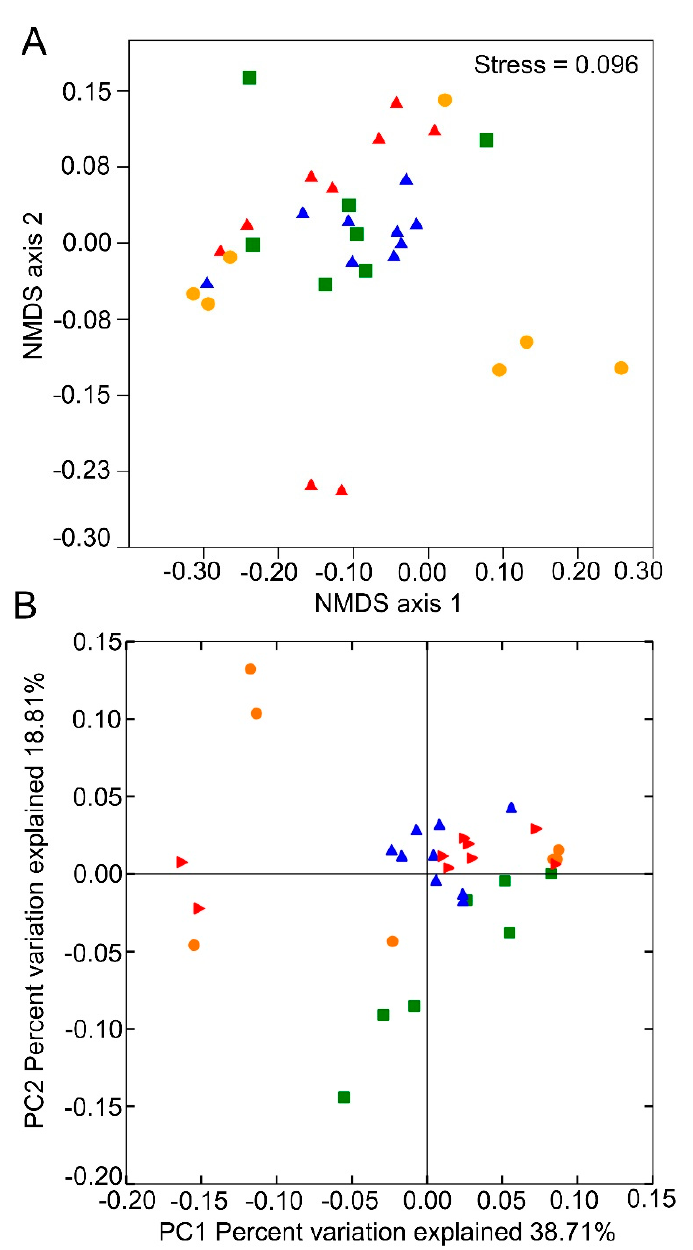
Figure 1. Non-metric multidimensional scaling (NMDS) and principal coordinates analysis (PCoA) of the bacterial communities in the gut of di ff erent life stages of D. valens . ( A ) Non-metric multidimensional scaling diagrams of 32 samples, based on Bray-Curtis distance matrix for bacterial communities that consisted of operational taxonomic units (OTUs) (97% similarity level). ( B ) Principal coordinate analysis plots based on the weighted UniFrac metric for bacterial communities. The red triangle represents young larval gut samples, the green square represents old larval gut samples, the orange circle represents dispersal adult gut samples, and the blue triangle represents female colonized adult samples.